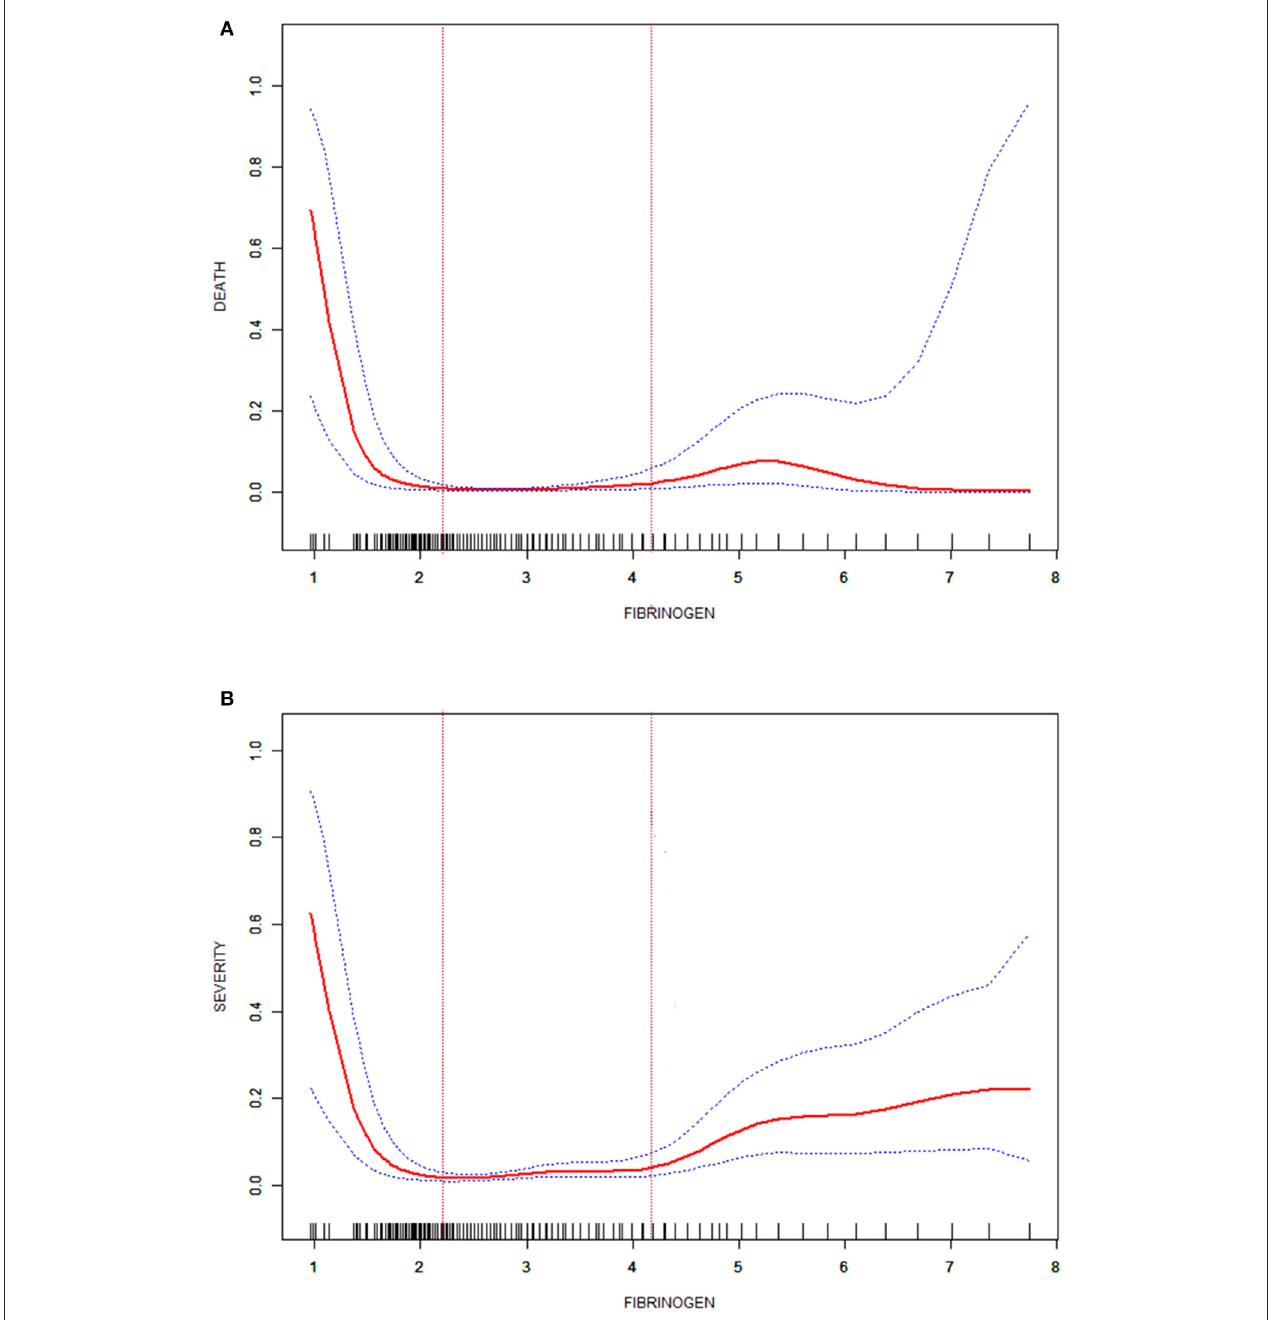
FIGURE 1 | Fitted curve of the fibrinogen level and death in patients with COVID-19 (A) ; fitted curve of the fibrinogen level and severity in patients with COVID-19 (B) .